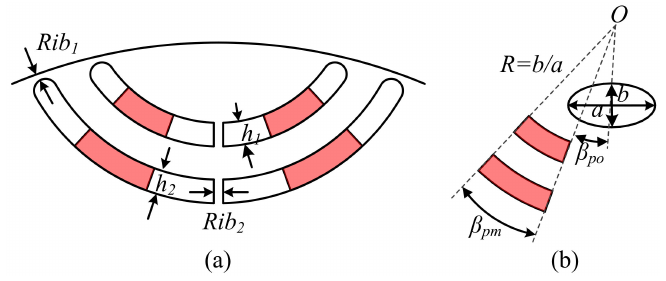
Figure 3. Geometric parameters: ( a ) The parameters related to the maximum stress zone. ( b ) The parameters related to the maximum deformation zone. Table 3. Optimization